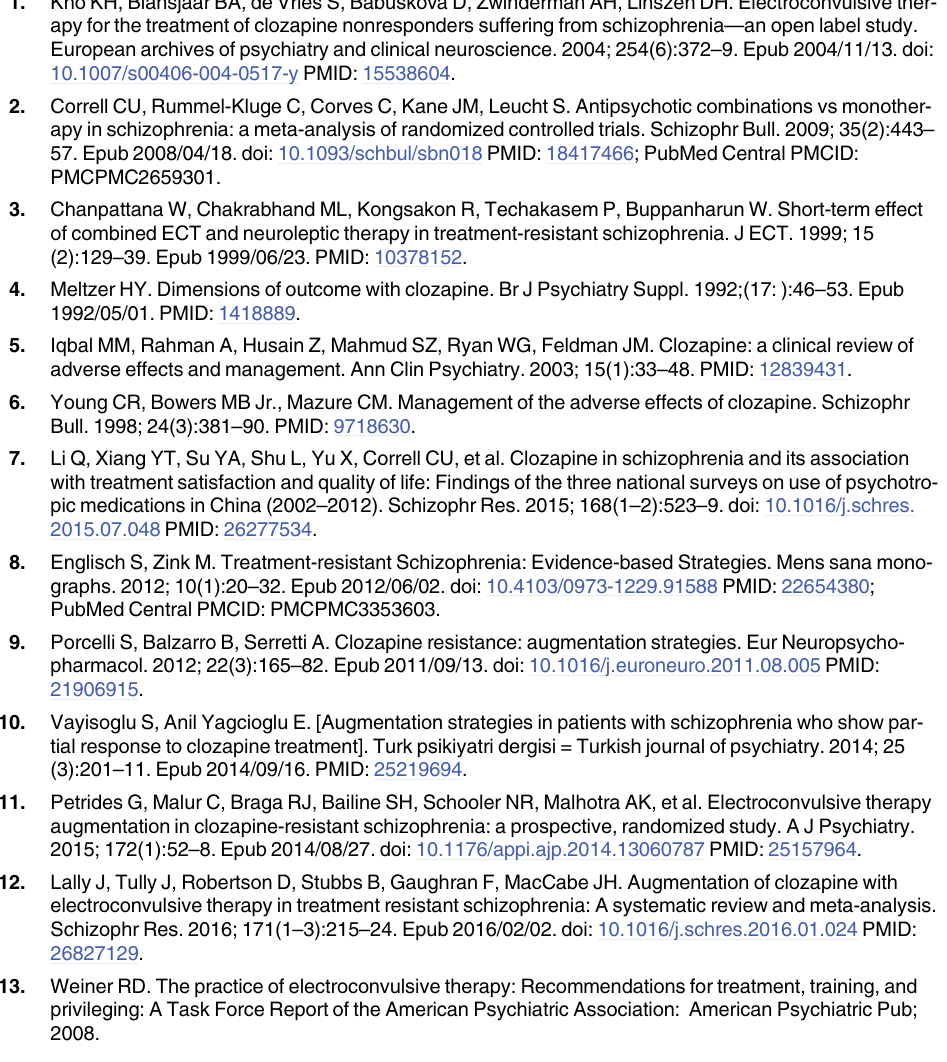
S5 Fig. ECT added to non-clozapine antipsychotic medications for treatment resistant schizophrenia: adverse drug reactions. S1 Table. GRADE analyses: ECT added to non-clozapine antipsychotics for treatment resis- tant